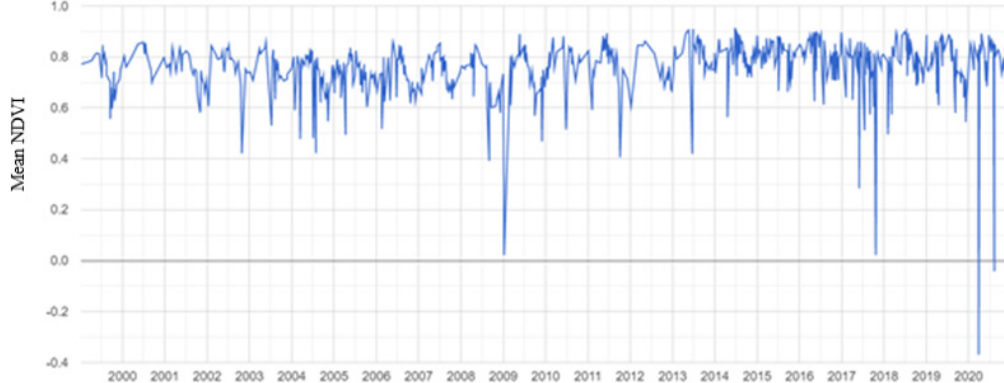
Figure 5. Mean NDVI temporal pattern across the dense Landsat time series (1999–2020) for mangrove forest in the mid-section of our study region. The site is located directly adjacent to Koumala Station, Figure 1, Bowen to Shoalwater and Corio Bays Area Ramsar Wetland, Central Queensland.